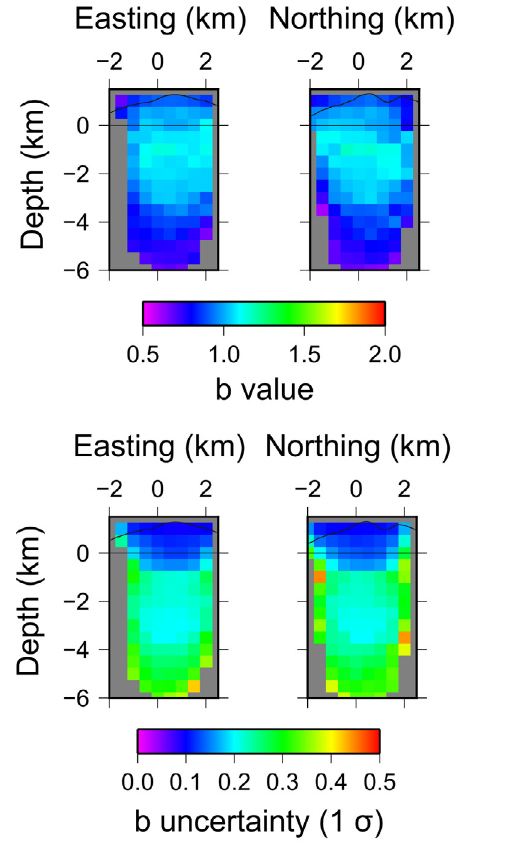
Figure 10. Spatial distribution of the b-value. The two panels on the top represent the b-value distribution along an EW (left) and a NS (right) cross-section. The two cross-sections intersect on the Mt. Vesuvius crater. The bottom panels represent the uncertainty on the retrieved